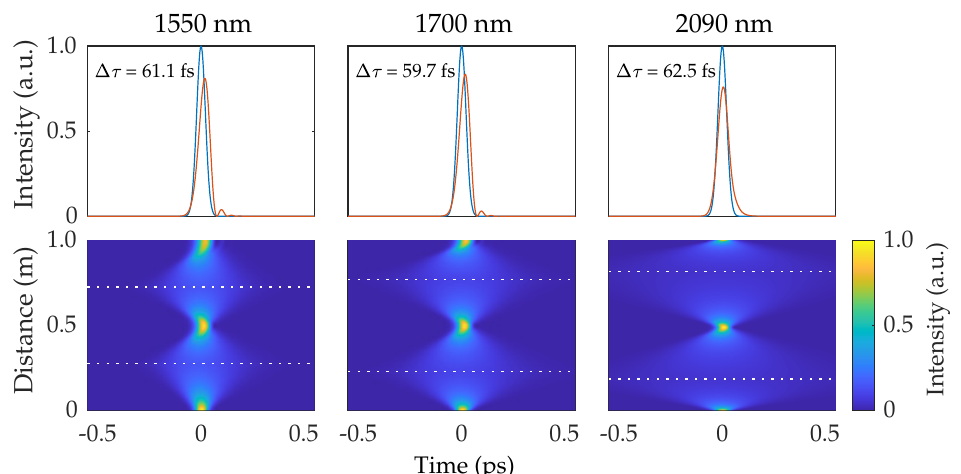
Figure 6. Top row: pulse temporal intensity before (blue) and after (red) propagation through SMF-28 and UHNA7. Bottom row: evolution of the temporal intensity profile through the system of cascaded fibers. White lines indicate transitions between different